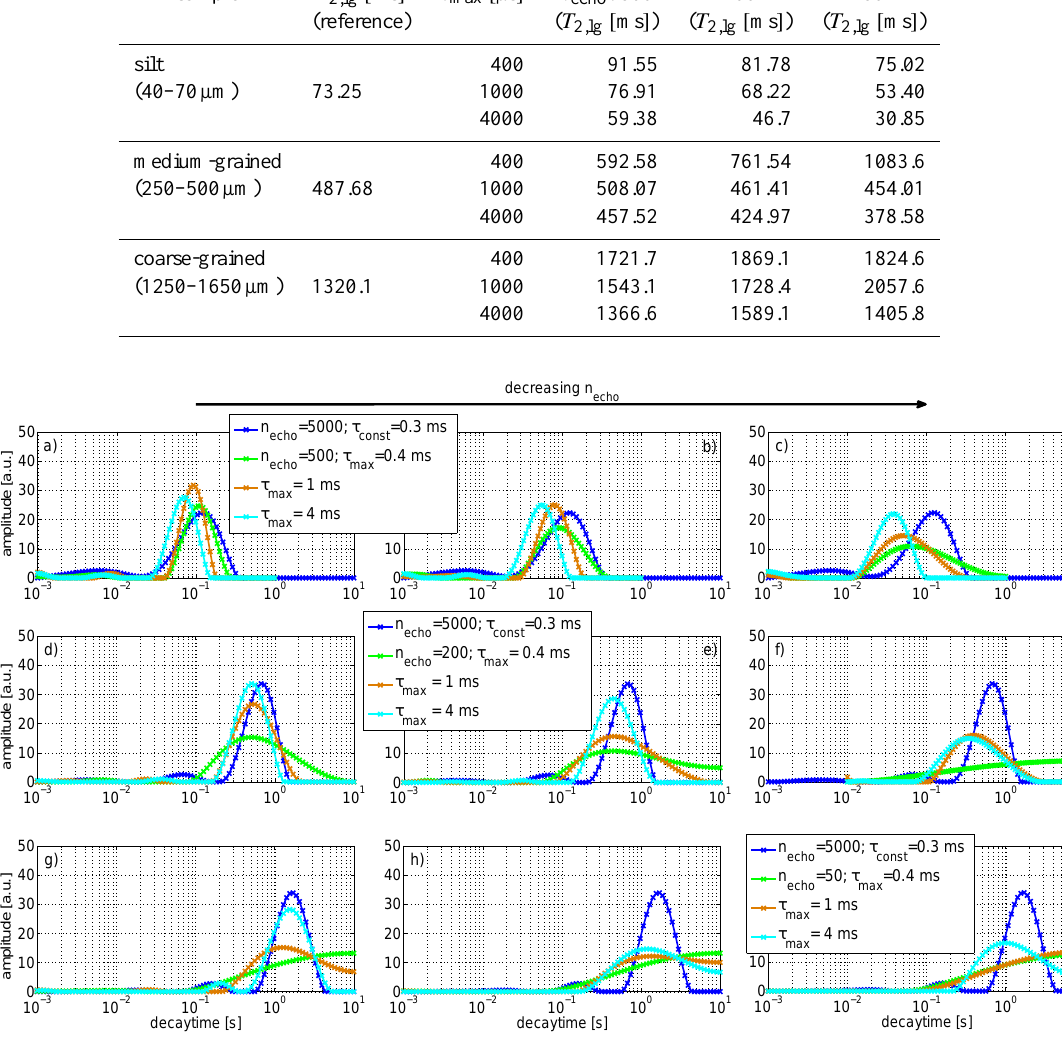
Fig. 7. T 2 distribution of glass beads for CPMG sequences with a linearly increased τ . Columns indicate a decreasing n echo (500–200–50, also given in the legends). The grain size increases from top to bottom (first row – coarse silt; second row – fine sand; third row – coarse